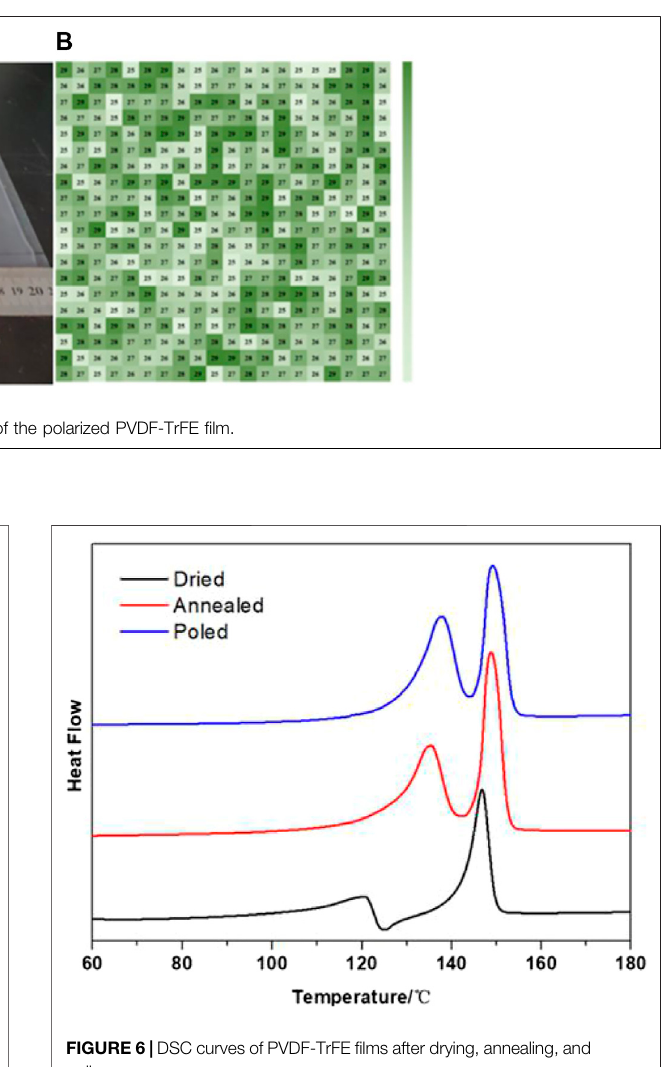
FIGURE 5 | XRD patterns of PVDF-TrFE fi lms after poling (A) , annealing (B) , and drying (C) .